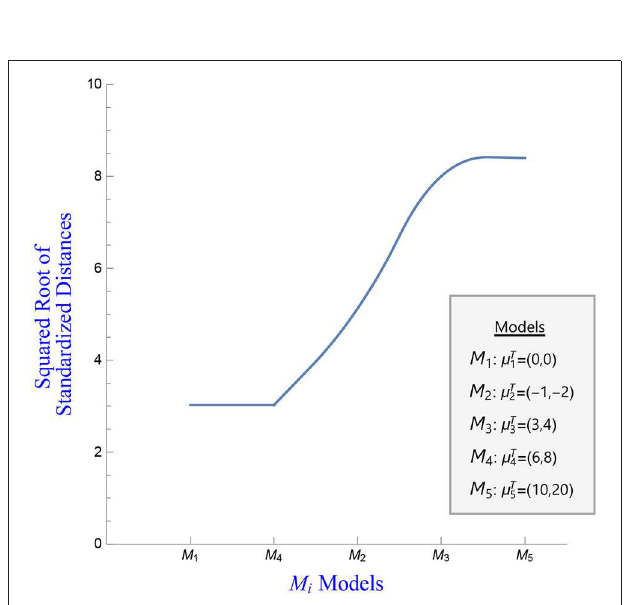
FIGURE 3 | L 1 , L 2 and Scale-Invariant Quadratic Distances between two univariate normal distributions N ( µ 1 ,1) & N ( µ 2 ,1), as a function of the mean difference µ 1 µ 2 . −